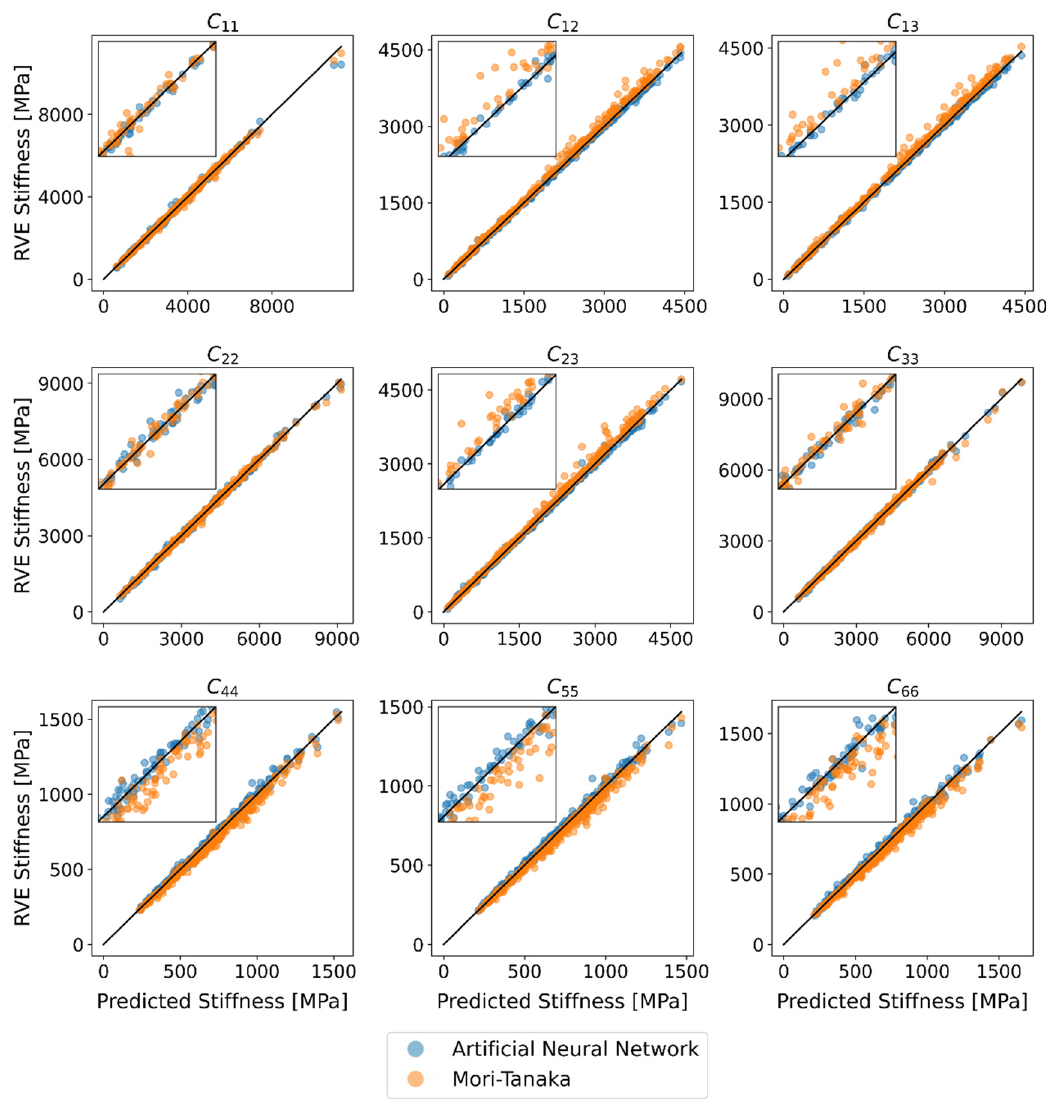
Figure 7. Comparison between Stiffness by RVE and Stiffness predictions by the neural network method (NN) and Mori–Tanaka Method (MT).